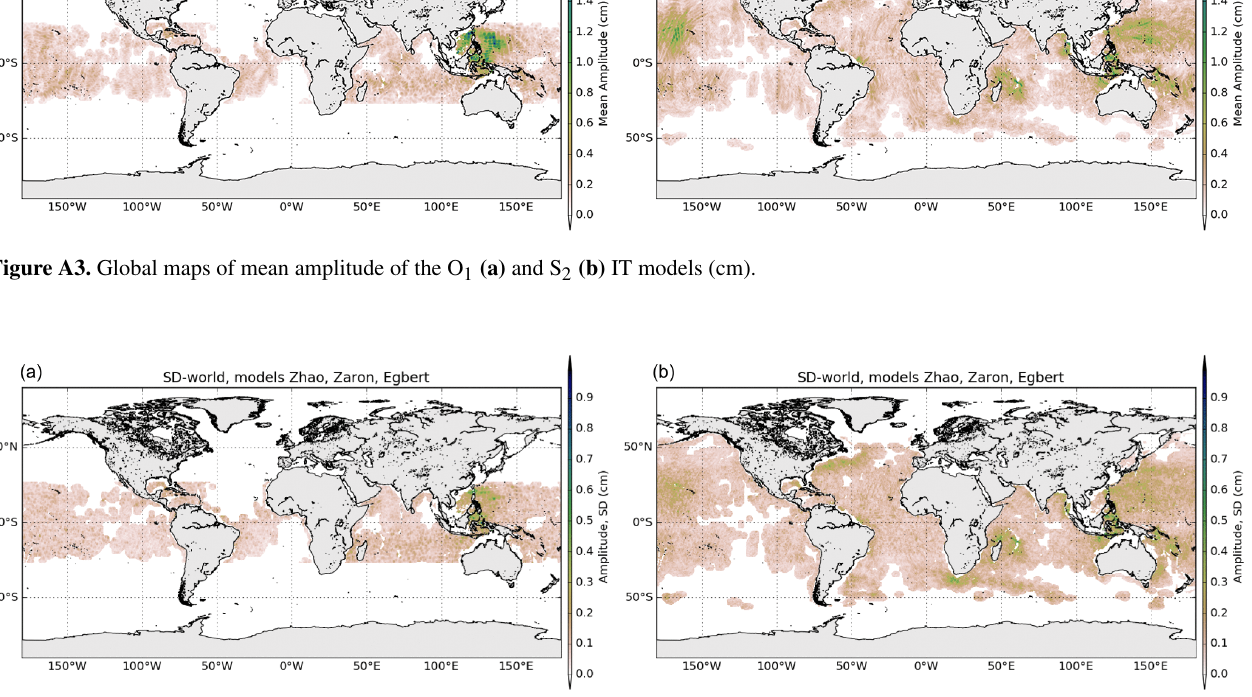
Figure A4. Global maps of standard deviation of the O 1 (a) and S 2 (b) IT models